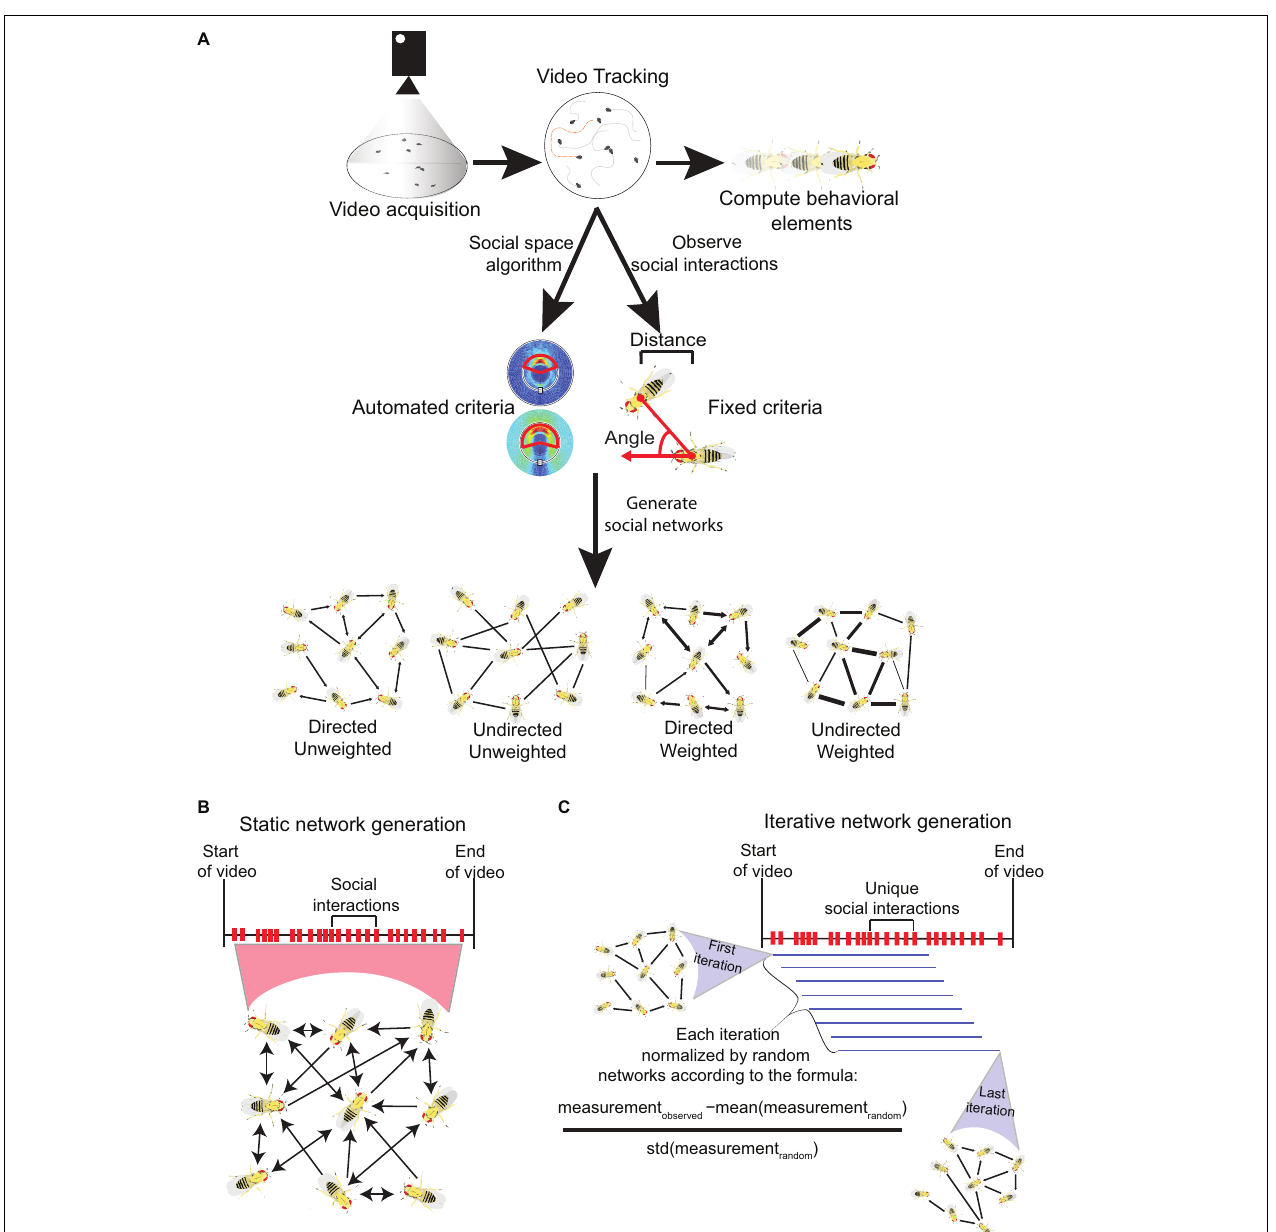
FIGURE 1 | Visualization of the methods involved in acquiring Drosophila social networks. (A) First videos with a specific number of flies confined in an arena are acquired and the position, orientation and identity of each fly is tracked with machine vision software (e.g., Ctrax). This information acquired from tracking can be used to calculate a variety of behavioral element measures such as the average locomotor activity of the flies. To generate networks, criteria that define a directed interaction are necessary. Typically, three parameters are used: (i) the angle connecting the center of the interactee fly relative to the interactor fly (shown with red arrows); (ii) the distance between the two flies’ center of mass; and (iii) how long these conditions must be maintained for. The criteria can be defined manually, based on observation (fixed criteria) or automatically computed through a published algorithm (automated criteria; see Schneider and Levine, 2014). Once the criteria are selected, social networks can be generated each time they are met in the tracked videos. Networks can be computed with the following properties: (i) directed - the directionality of incoming or outgoing interactions are recorded; (ii) undirected – the directionality of interactions are not recorded; (iii) weighted – interactions are weighted to reflect the strength or frequency of interactions between nodes; (iv) unweighted - networks are binary and only consider the presence or absence of interactions between individuals. (B) Visualization of static networks, a conventional form of SNA where every observed social interaction within a video sequence is combined into a single, large social network that encompasses the entire history of social interactions. To avoid saturation of node connections, static networks can be weighted. (C) Visualization of the iterative network method (published by Schneider et al., 2012) where a variety of network iterations are generated throughout a single video sequence. Once a threshold number of unique interactions are observed, one iteration is generated. Each subsequent unique interaction creates a new iteration where the oldest interaction is removed. Each iteration is normalized to randomly generated networks with equal degree distributions. All iterations also have the same number of interactions. As a result, degree distribution and density are controlled through this